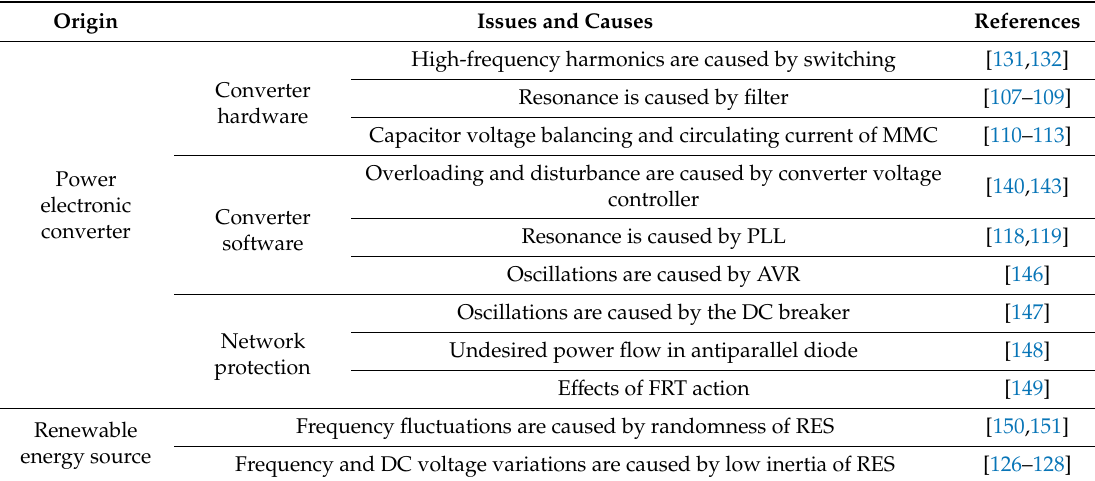
Table 1. Summary of stability issues and causes in hybrid AC / DC power